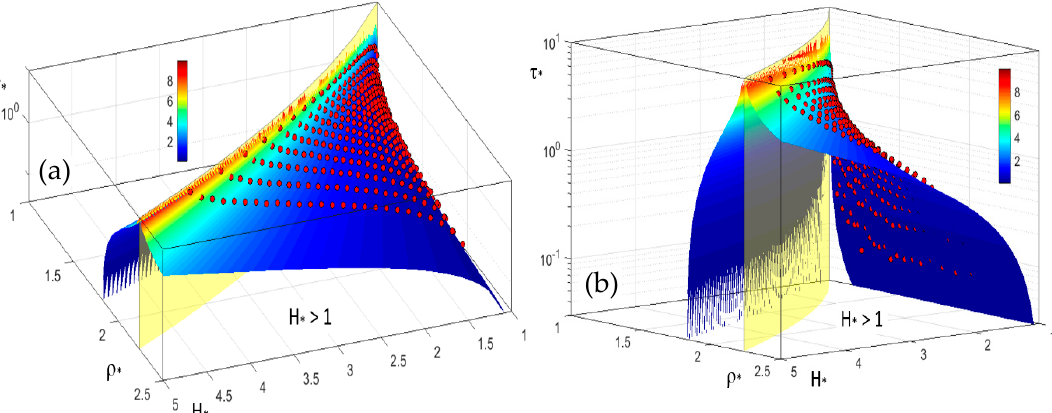
Figure 9. For H * < 1, two different 3D views (a) from the bottom and (b) from the top of the stage variation – discharge relationship (Equation (29)). The experimental triplet of values ( H * , ρ * , and τ * ) (red dots) are plotted.